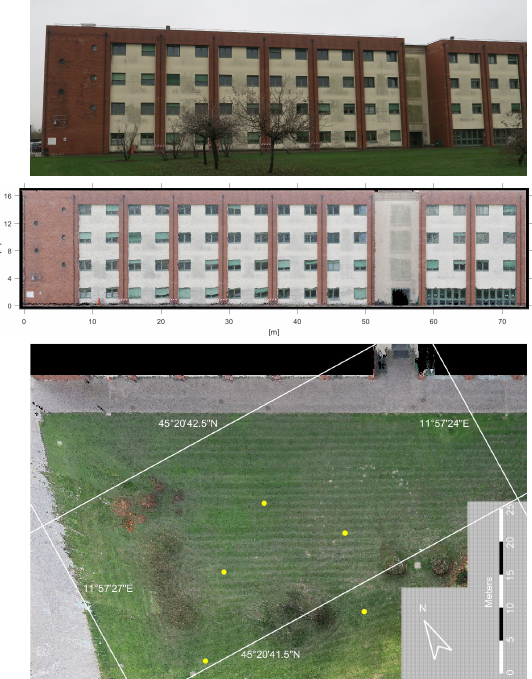
Figure 1. Façade of the university building considered as case study ( top ). Front view of the reconstructed façade ( middle ). Top view of the scene ( bottom ). Ground control point positions (used in the indirect georeferencing case) are shown in the bottom image with yellow